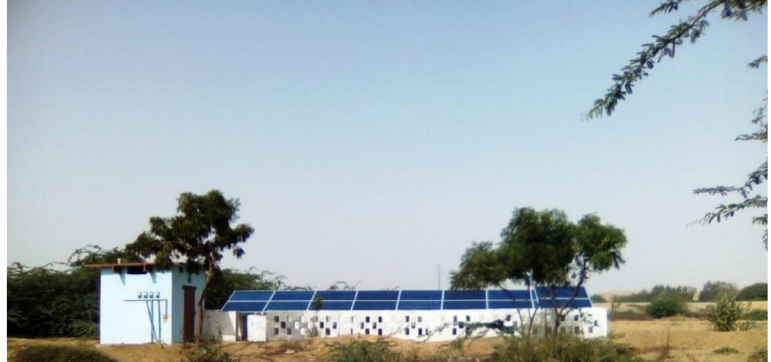
Figure 1. Actual installed microgrid.